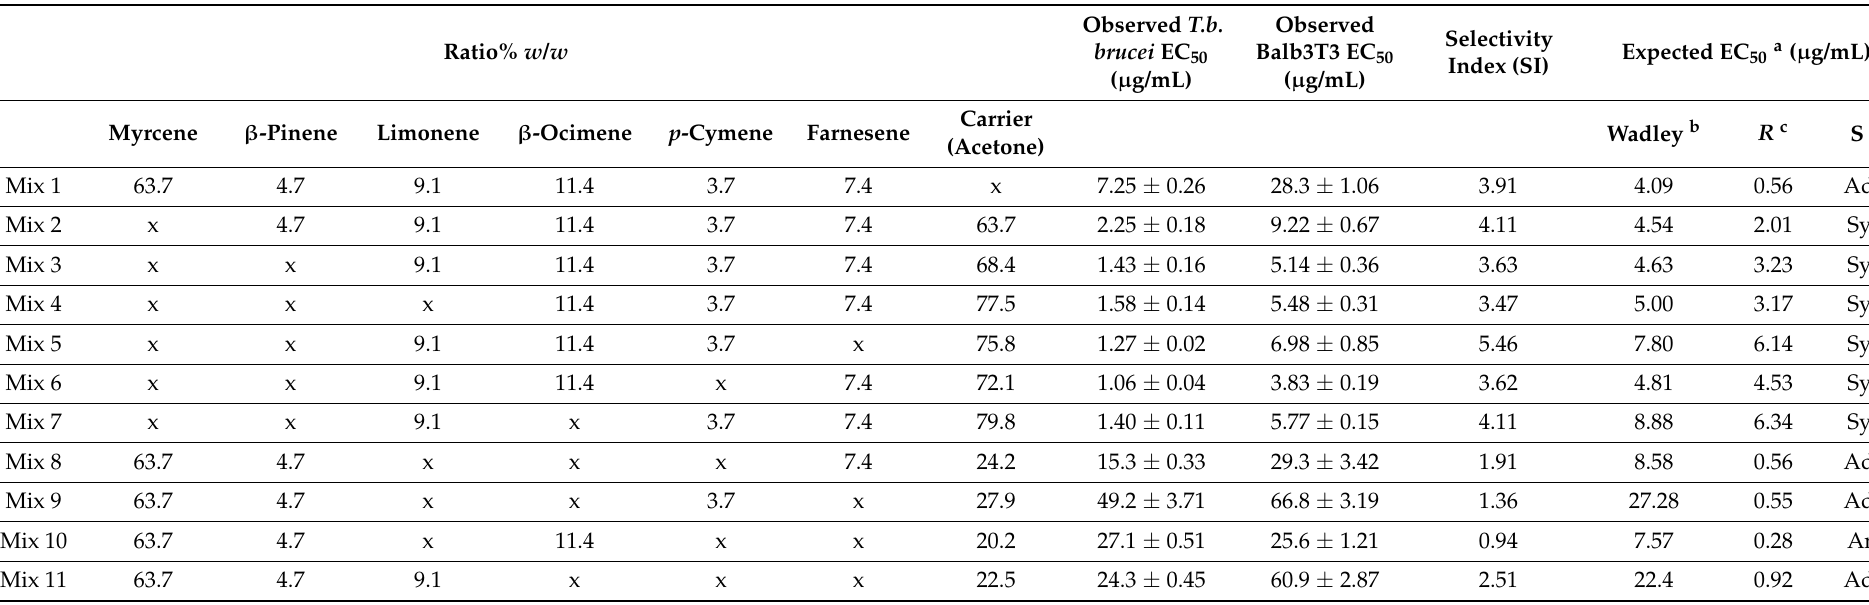
Table 3. Comparative antitrypanosomal activity of six major components of the EO from A. nemorosa aerial parts. Stock solutions were prepared of the complete mixture and different alternative mixtures where one or several components were replaced by